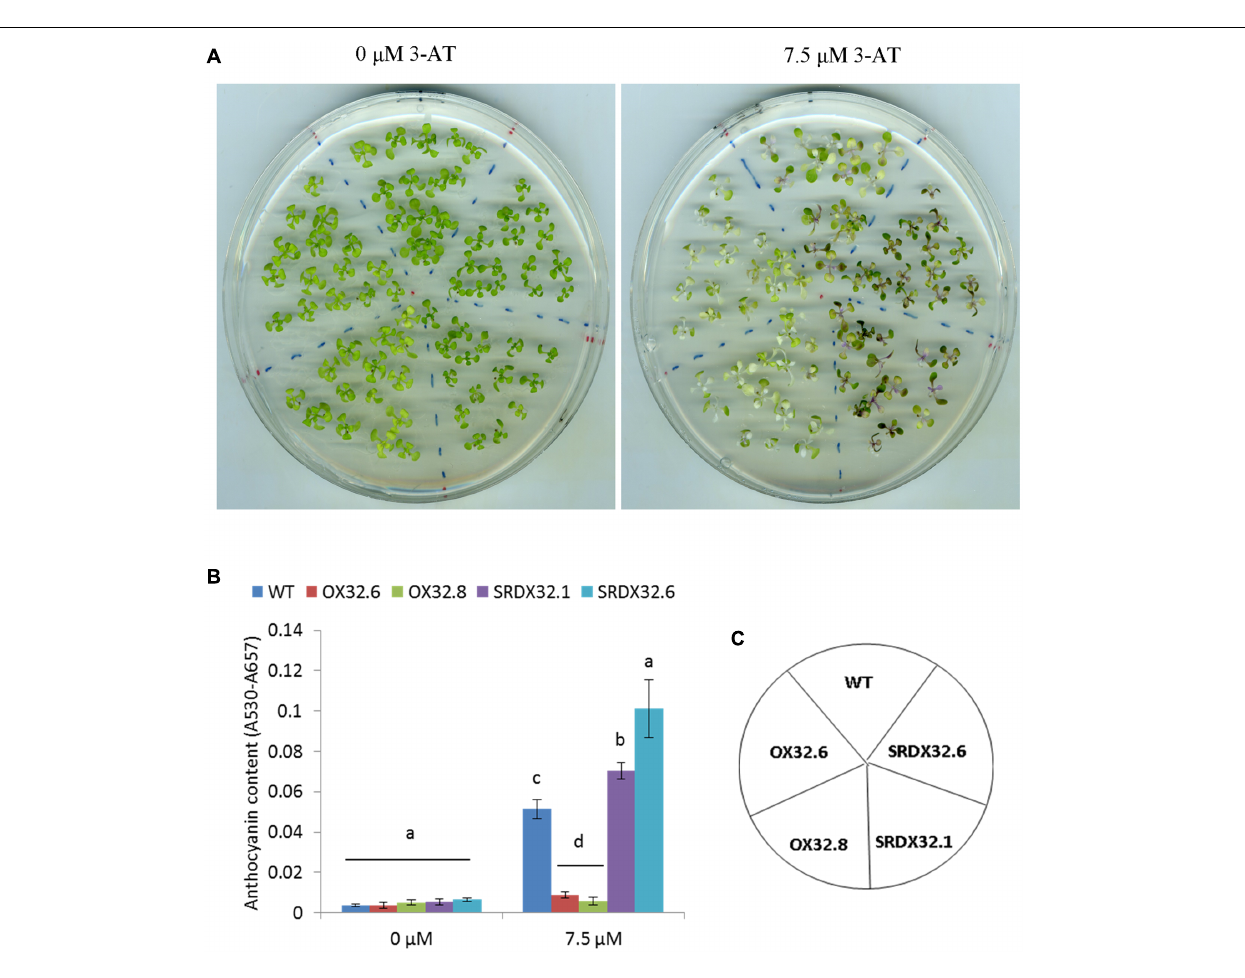
FIGURE 3 | Effect of 3-AT on anthocyanin biosynthesis in WT and ANAC032 transgenic lines. (A) Phenotypic response of WT and ANAC032 overexpression and SRDX lines for anthocyanin biosynthesis in response to 3-AT treatment after 17 days of growth under long-day conditions. (B) Biochemical analysis of anthocyanin content in WT and ANAC032 transgenic lines after 17 days on 0 and 7.5 µ M of 3-AT. (C) Template showing the position of the genotypes shown in (A) . Data represent mean values from three biological replicates. Within each treatment, bars with different letters are not statistically similar to each other according to one way ANOVA LSD test ( P <